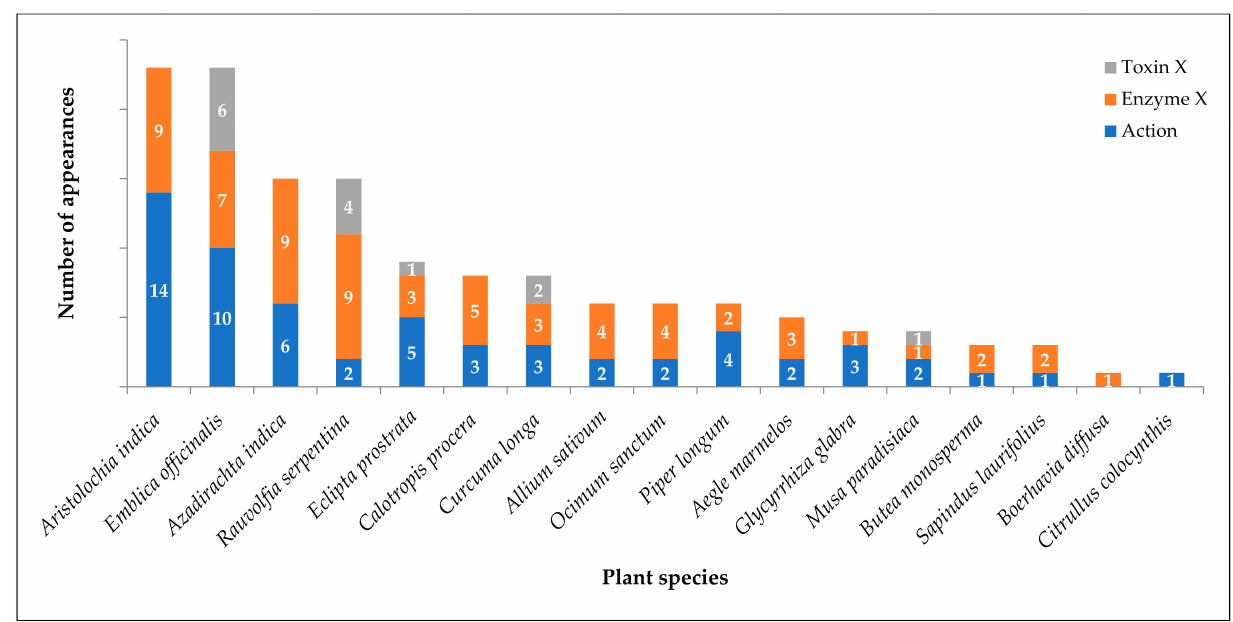
Figure 3. Modern literature evidence on plant species that inhibit snake venom and its components.